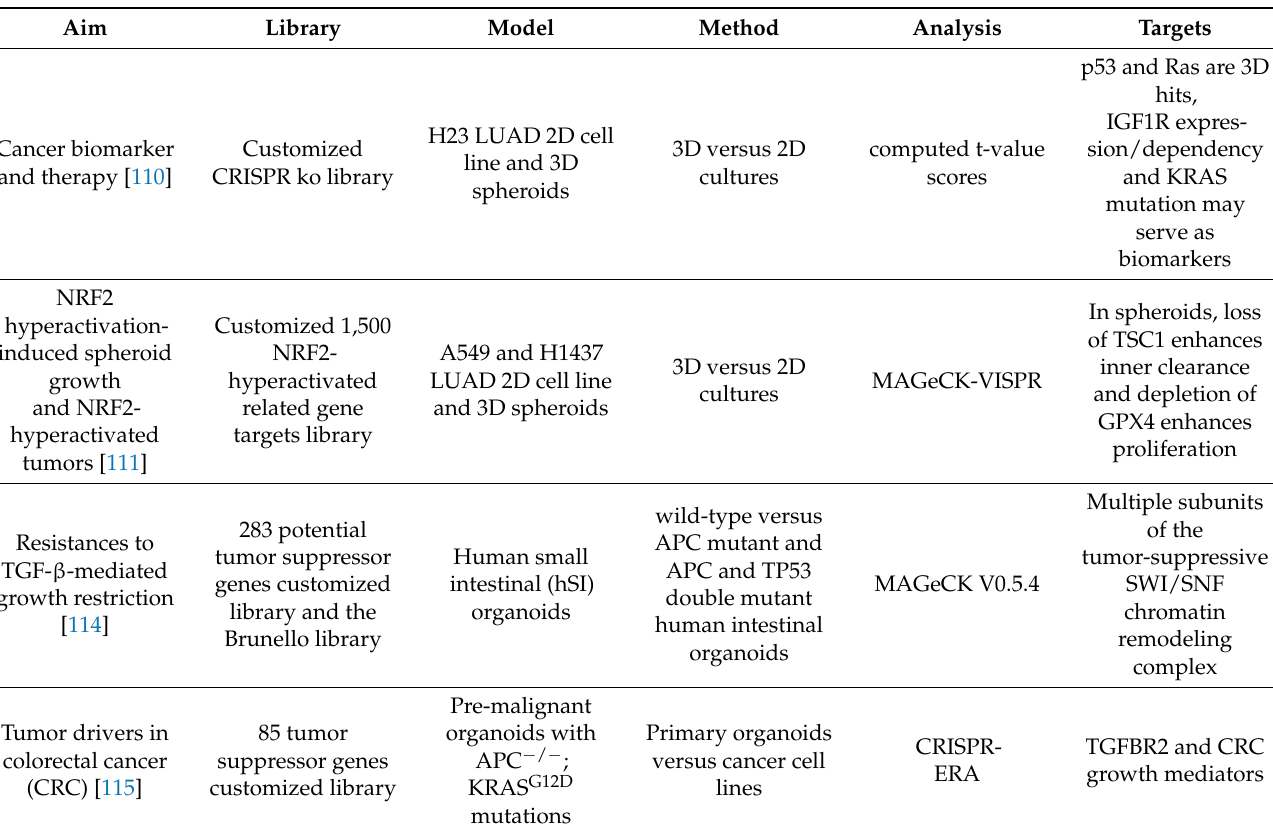
Table 3. 3D cultured cancer model CRISPR